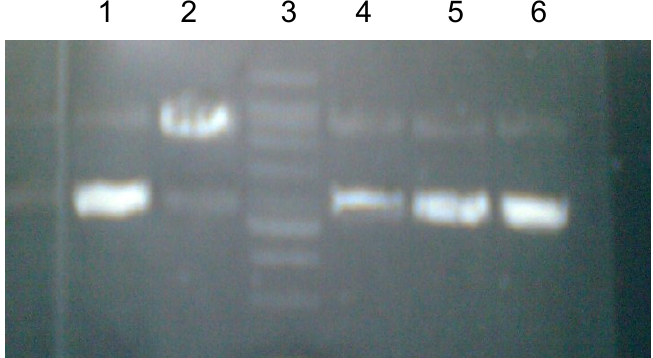
damage on pBR322